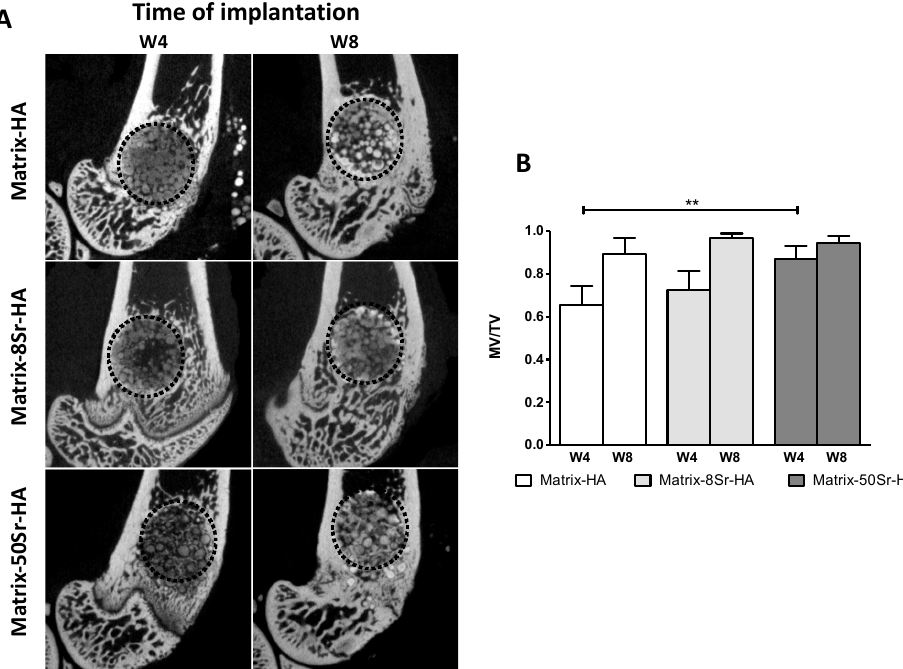
Figure 3. Micro-CT analysis of the tissue formed within the Matrix-HA groups, supplemented or not with strontium: ( A ) Representative Micro-CT images of these matrices 4 weeks (W4) and 8 weeks (W8) after implantation within the femoral condyle bone defect. The defect is represented with the black dote circle. ( B ) Quantification of the mineralized volume/total volume (MV/TV) 4 weeks (W4) and 8 weeks (W8) after implantation. Eight samples were evaluated for each condition (Matrix-HA, Matrix-8Sr-HA, and Matrix-50Sr-HA) at each time point (4 and 8 weeks). Results are expressed as average ± SD. The symbol ** denotes p < 0.01 for Matrix-50Sr-HA versus Matrix-HA at 4 weeks.